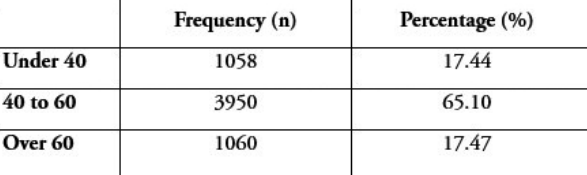
Table 1: Age distribution of MEPs since 1979, at the start of a term